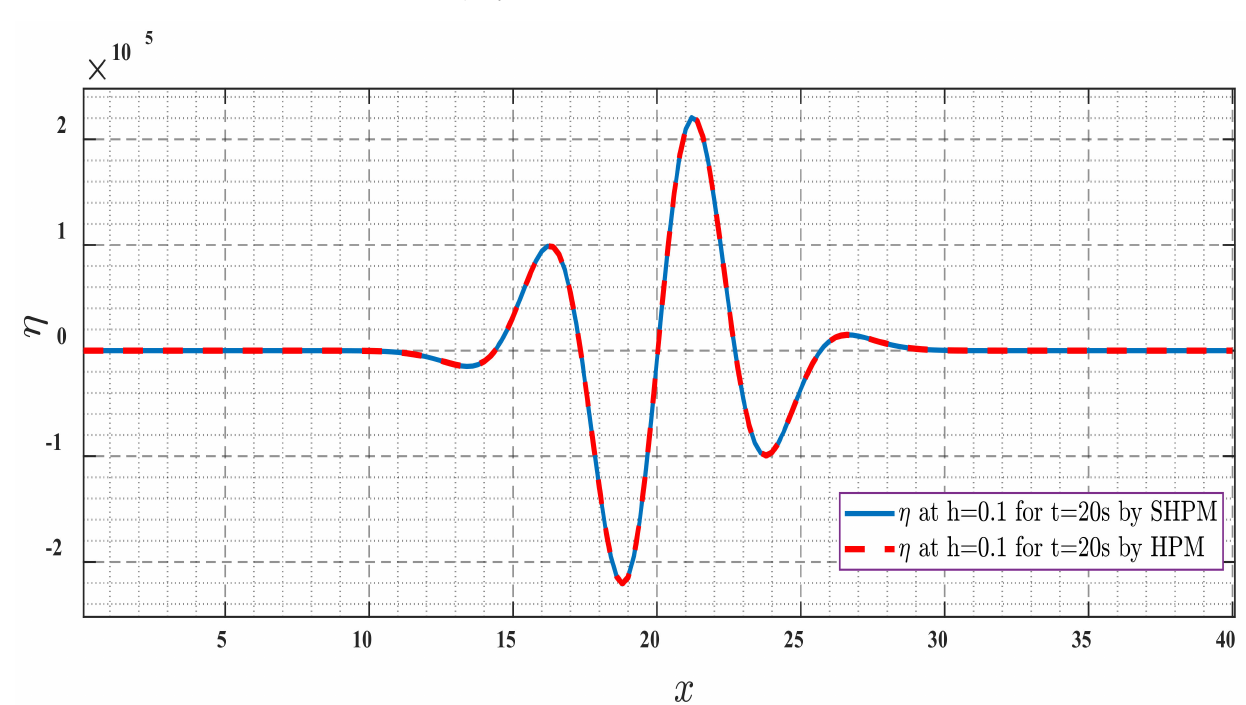
Figure 9. WSE ( η ) by SHPM and HPM at t = 20 s ( h = 1.0 ).